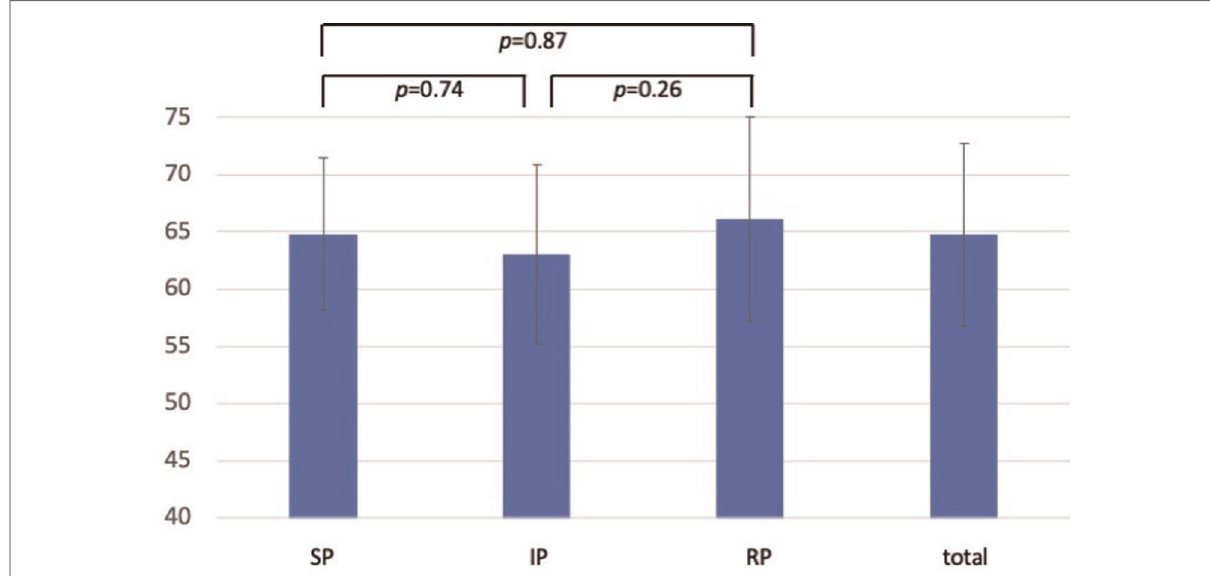
FIGURE 1 OSCE results for content-related items ( fi rst part of the evaluation sheet). Results of the rating for the content-related items. Data are presented as the mean±standard deviation of the achieved results as a percentage. (SP-group, simulated patient group; IP-group, incognito patient group; RP-group, real patient group).